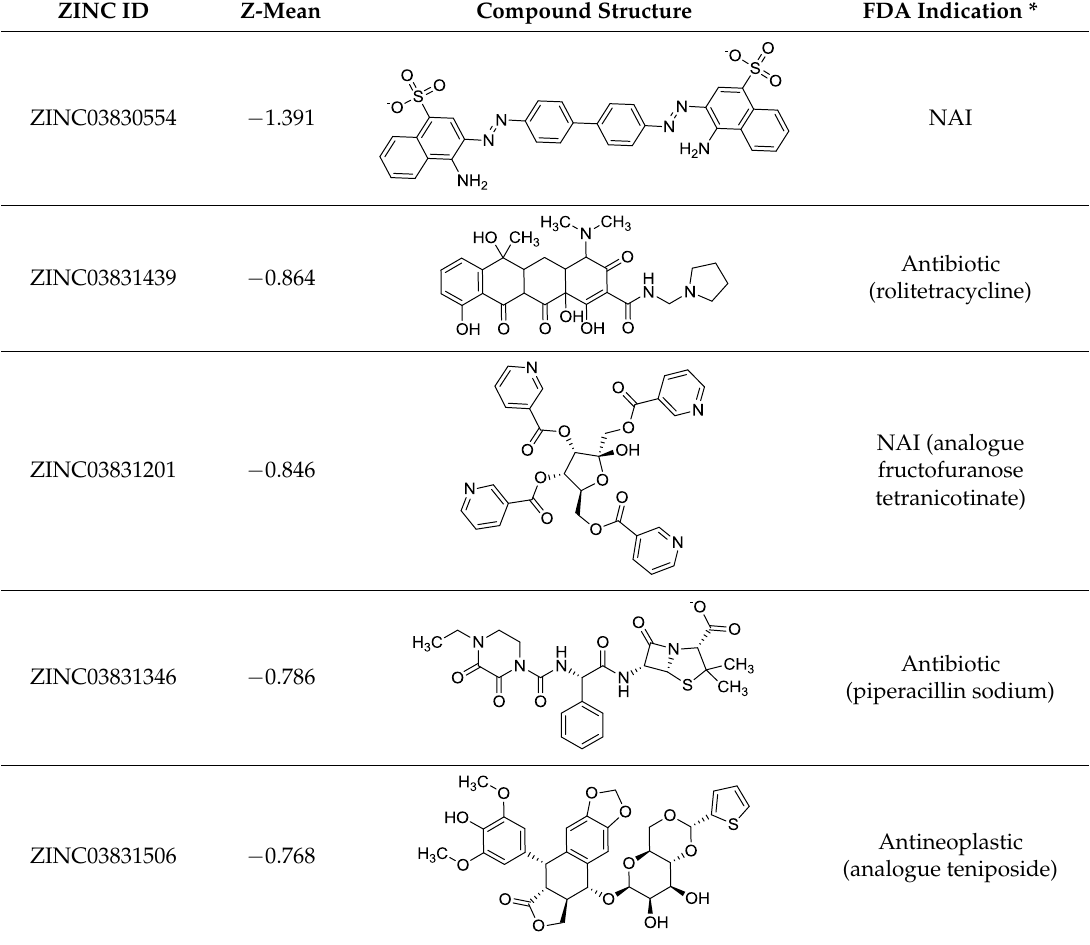
Figure 1. Structural comparison of the 4W5B protein with 1F2A protein. In green the 4W5B protein, in pale cyan the 1F2A protein that contain the known catalytic triad. The catalytic amino acids indicated by arrows are colored as follow: 1F2A in magenta and 4W5B in red. The compound N -(1H-benzimidazol-2-yl)-1,3-dimethyl-pyrazole-4-carboxamide is shown in blue. Table 1. The Z-mean values used for ranking the potential Cz inhibitors and their FDA indication.